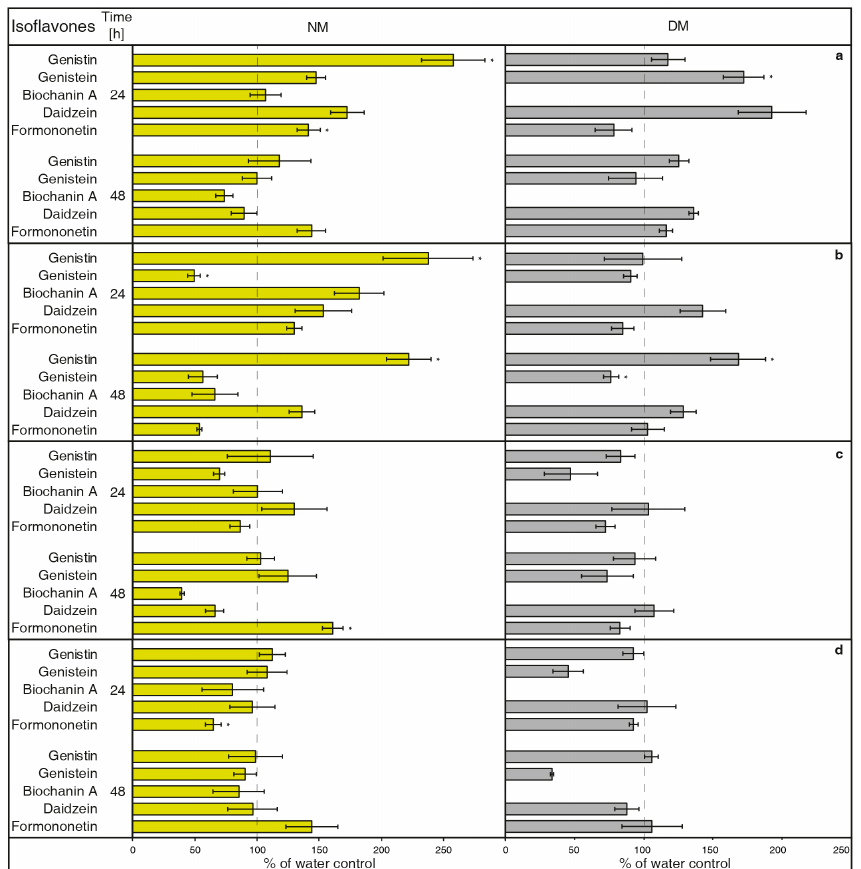
Figure 1. Effects of elicitors on isoflavone content in nutrient medium (NM) and dry matter (DM) after 24 or 48 h. Genista tinctoria cell culture was treated by 1 μ M ( a ) or 10 μ M ( b ) of NH 4 VO 3 and 1 μ M ( c ) or 10 μ M ( d ) of VOSO 4 . Bars indicate isoflavone levels in treated samples recalculated to a relative 100% isoflavone content in water control samples. Data are mean of three repeats ± SE; (*) represent significant difference ( p < 0.05) between tested and water control samples within Tukey’s test.